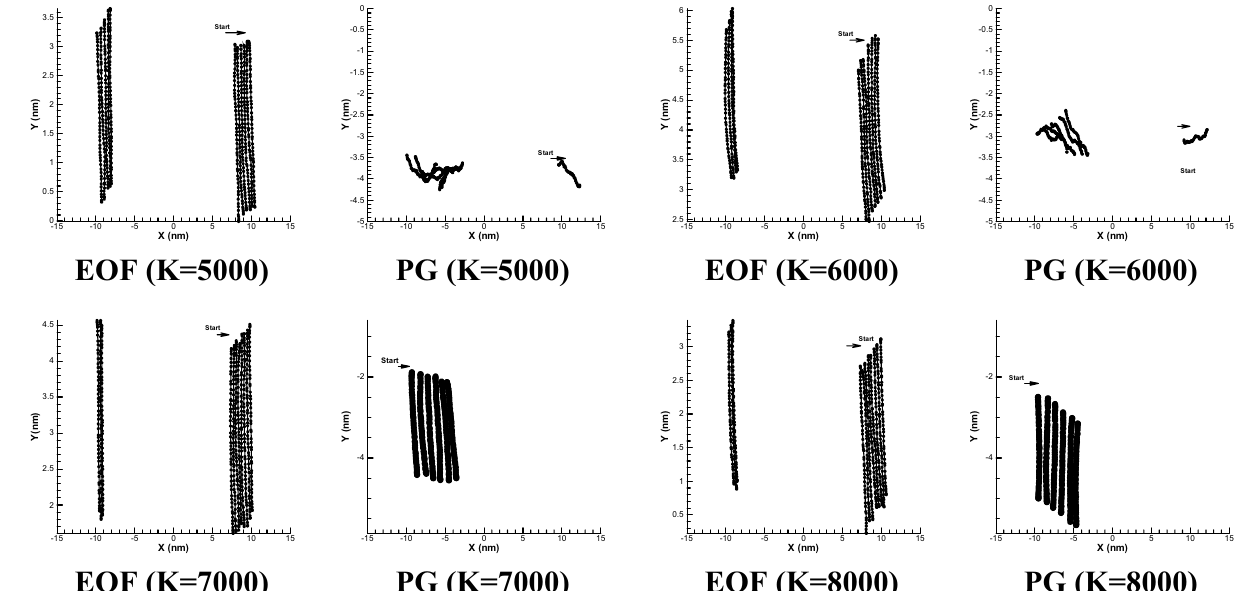
Figure 4. Free movement of the polymer chain in a simple channel under the influence of a constant external force (PG of 0.01 DPD unite) and electroosmotic force (EOF) with different spring coefficient between the beads over time for n =